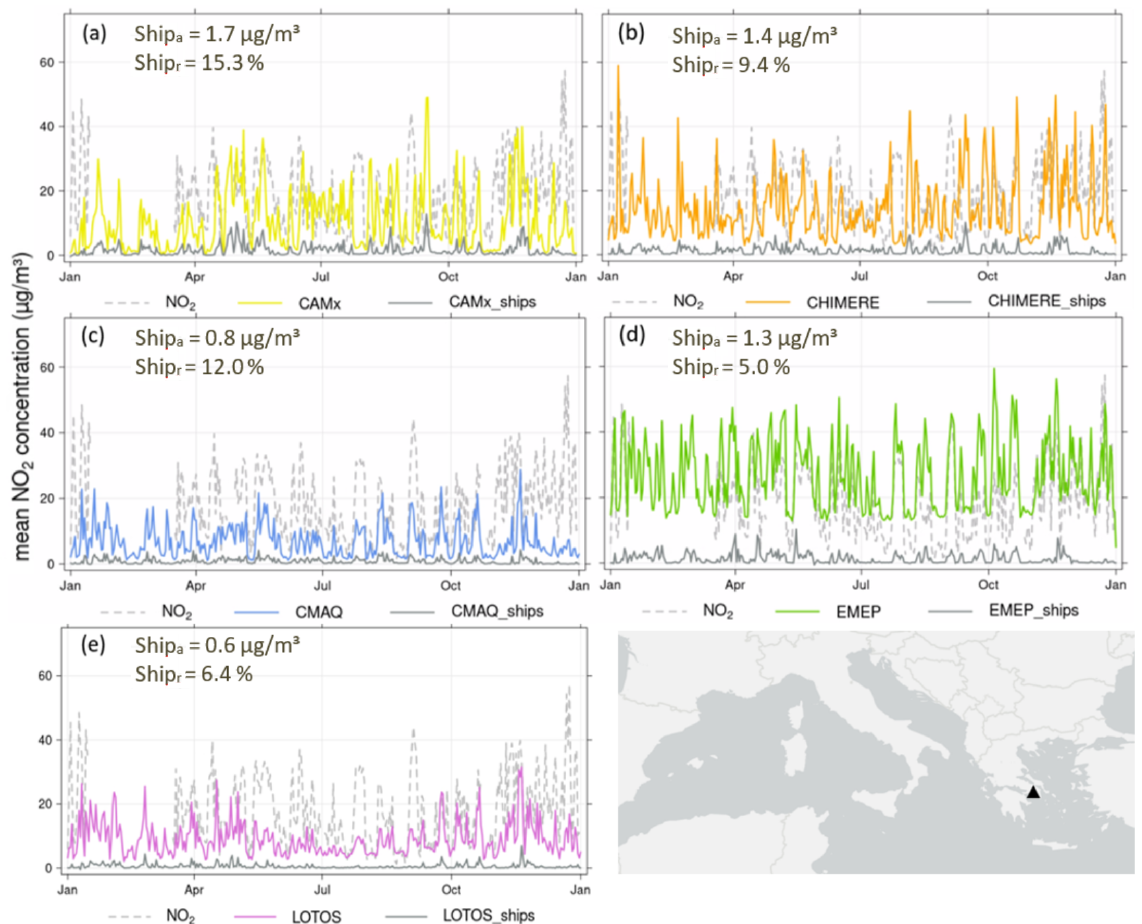
Figure C3. Time series with daily mean NO 2 concentration in 2015 at station gr0035a in Greece. The black triangle on the map (bottom right) displays the location of the station. (a) CAMx; (b) CHIMERE; (c) CMAQ; (d) EMEP; (e) LOTOS-EUROS. Dashed gray line – measured data; colored lines – modeled data; gray line – modeled potential ship impact. Correlation between modeled and measured data for hourly total emission data for 2015: CAMx = 0 . 15; CHIMERE = 0 . 20; CMAQ = 0 . 28; EMEP = 0 . 55; LOTOS-EUROS = 0 . 38. Ship a : potential absolute ship impact; Ship r : potential relative ship impact of the respective